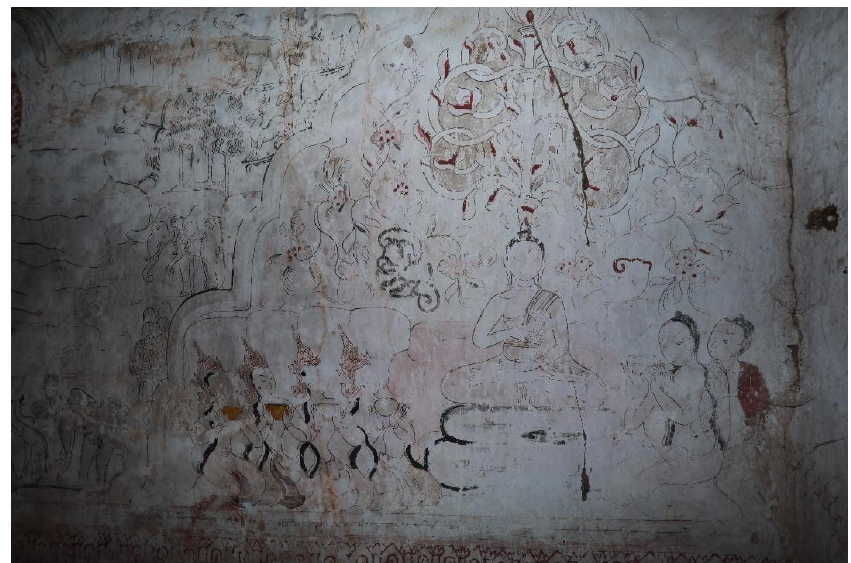
Figure 8. Trapu ṣ a and Bhallika offering refreshments and the four World Guardians offering alms Figure 8. Trapus.a and Bhallika o ff ering refreshments and the four World Guardians o ff ering alms bowls to the Blessed One, the Seventh Week, Sulamani temple, Bagan. bowls to the Blessed One, the Seventh Week, Sulamani temple,